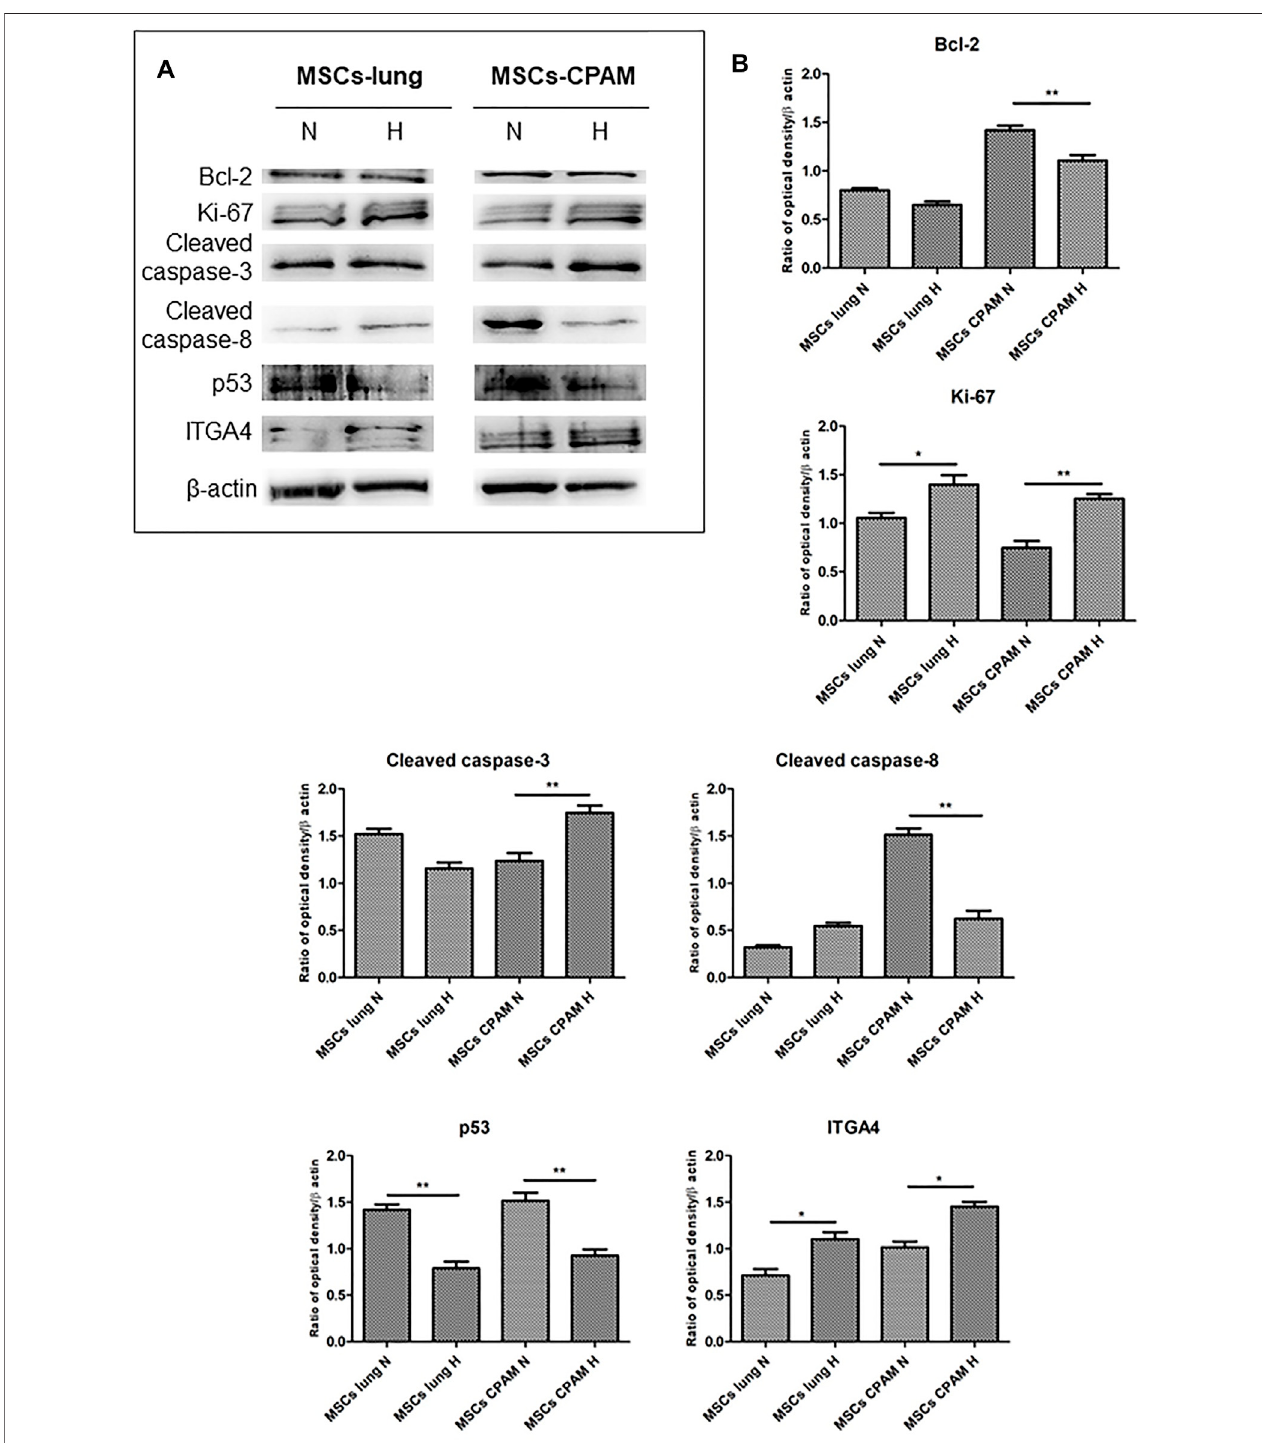
FIGURE5 | MSCs-lung and MSCs-CPAM protein expression under Normoxic (N)and Hypoxic (H) conditions. (A) Speci fi c bandof investigated markers Bcl-2, Ki- 67, Cleaved caspase-3, Cleaved caspase-8, p53 and ITGA4. Beta-actin was used as housekeeping protein. (B) Densitometric analyses of the studied markers. * < p < 0.05; ** p <